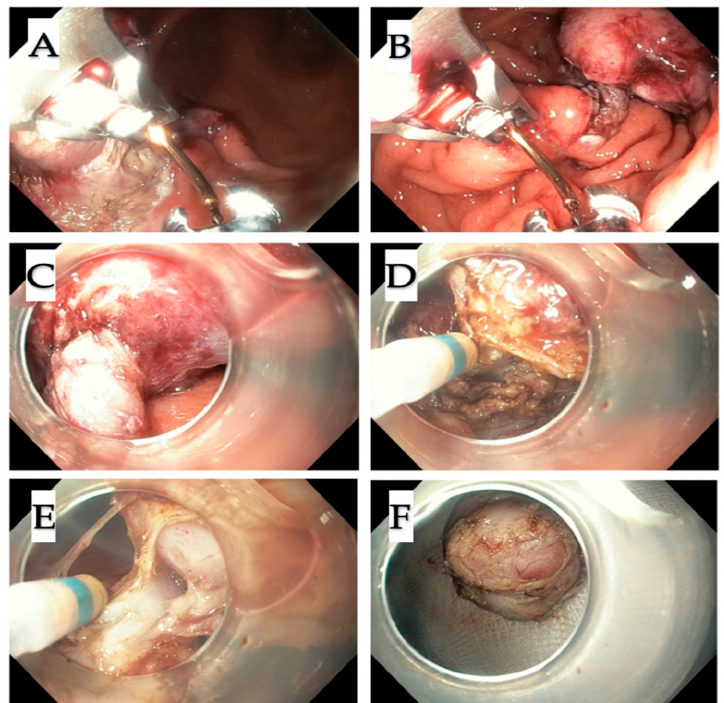
Figure 5. Step three. Step three. ( A , B ) After revealing the connection of the tumor with the deep layer of the muscularis propria, the adjacent gastric folds have been again brought together in another site ( C – F ) to lift up the resection site, allowed for safe and transmural cut o ff the tumor; ( A , B ) successive sutures were inserted ( C – F ) to enucleate it completely from the MP layer, thus the full-wall resection was